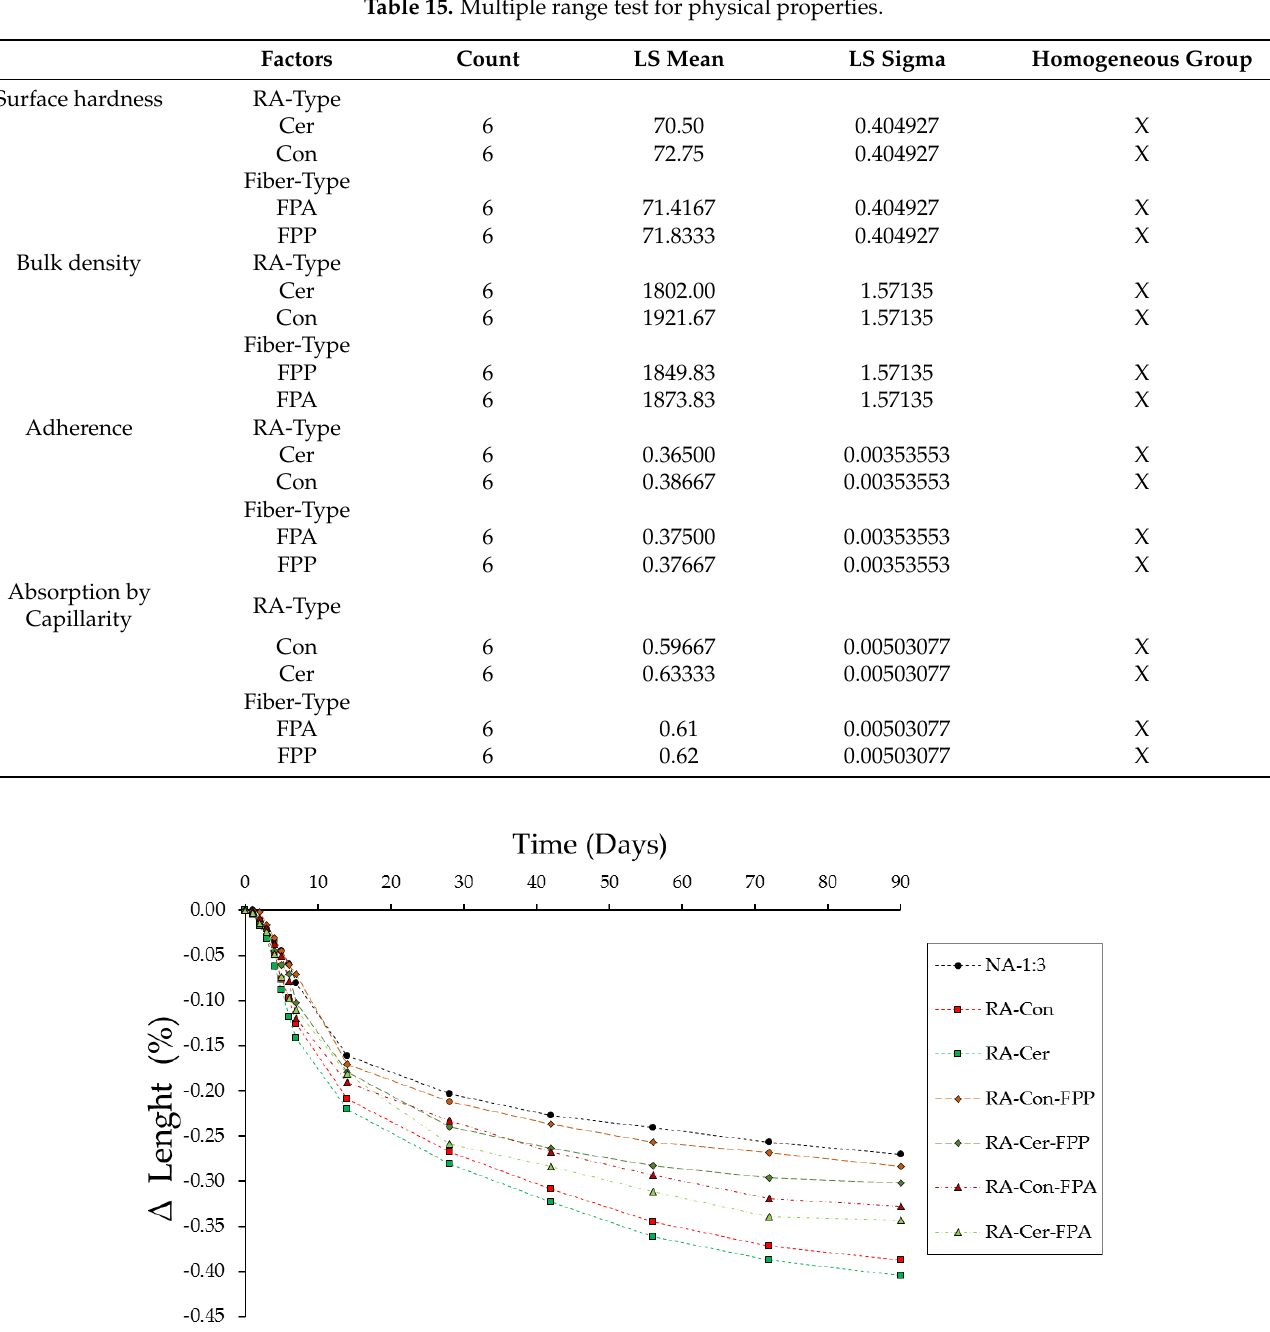
Figure 6. Evolution of the retraction during the setting. Variation of the percentage of shortening versus time in days.